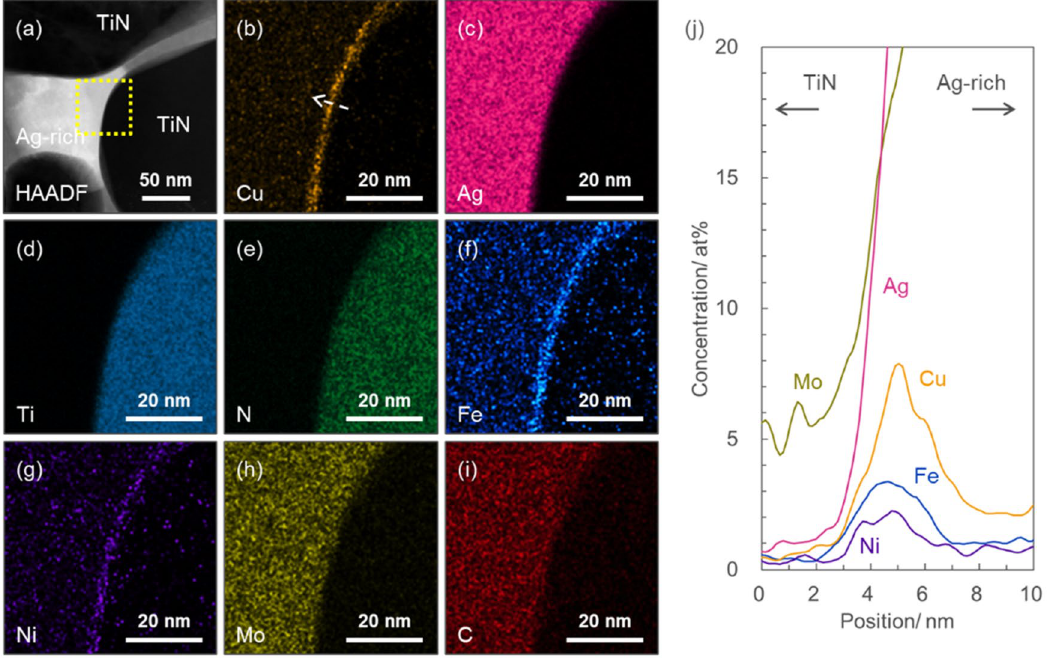
C obtained from the selected area marked in ( a ) by EDS. j Line EDS profile obtained along the white dashed arrow shown in ( b